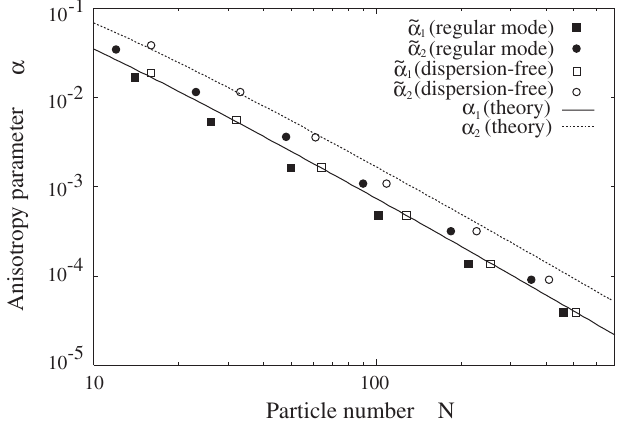
FIG. 7. Anisotropy parameter ~ (cid:10) of bunched crystalline beams. The two lines represent the boundaries of the 1D-to-2D transi- tion and of the 2D-to-3D transition theoretically predicted by Dubin [Eq. (14)]. The theory says that, in the region below the solid line, the crystalline configuration is the 1D string while it becomes a 3D shell above the dotted line. MD results are indicated with open and filled marks corresponding, respectively, to the dispersion-free and regular operations of Test Ring